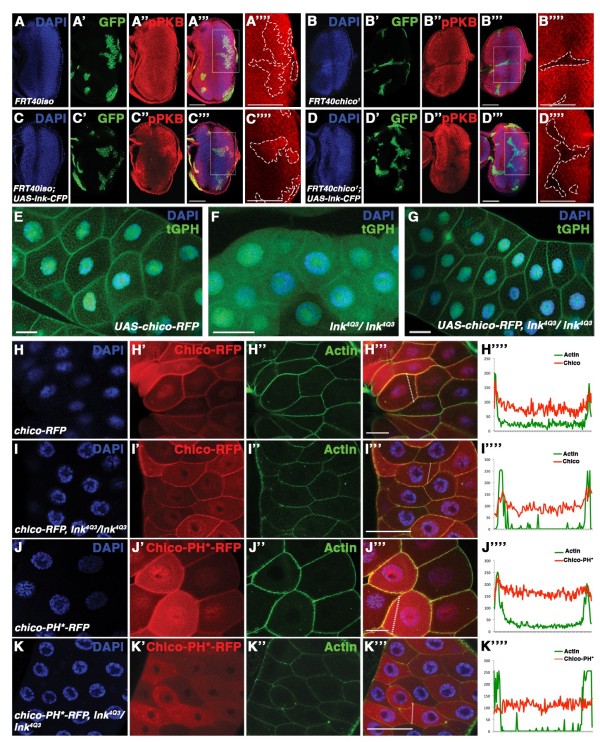
Lnk acts upstream of Chico ensuring its proper localisation. (A-D) Low phospho-PKB levels in chico−/− MARCM clones are not rescued by overexpression of lnk-CFP. Clones are marked by GFP expression (’ panels) and outlined by a dashed line in the detail pictures (”” panels). Phospho-PKB staining is shown in ” panels. (A-A””) control clones. (B-B””) Levels of phospho-PKB (B”) are decreased in chico−/− clones. (C-C””) Overexpression of lnk-CFP within control clones promotes high levels of phospho-PKB (C”). (D-D””) lnk-CFP overexpression within chico−/− clones does not rescue low levels of phospho-PKB (D”). (E-G) Chico overexpression restores localisation of the tGPH reporter at the membrane in lnk−/− salivary glands. (E) tGPH reporter localises at the membrane in wild-type salivary glands. (F) lnk4Q3 salivary glands show diffuse tGPH reporter signal in the cytoplasm. (G) tGPH reporter is recovered to the membrane of lnk4Q3 tissue by overexpressing chico. (H-K) Subcellular localisation of RFP-tagged Chico. The RFP signal is shown in ’ panels. Actin staining marks the cellular cortex in ” panels. Merged pictures are shown in ”’ panels. Signal intensities along the lines indicated in the ”’ panels are displayed in ”” panels. Quantifications in Additional file 1: Figure S1A. (H-H””) Cortical localisation of Chico-RFP in a wild-type situation. (I-I””) Chico-RFP in a lnk mutant background. (J-J””) A PH domain mutant form of Chico localises at the cortical membrane. (K-K””) Chico-PH*-RFP in a lnk mutant background. Number of samples analysed: (A) n=9, (B) n=9, (C) n = 10, (D) n = 12, (E) n=5, (F) n=5, (G) n=6, (H) n=6, (I) n=9, (J) n=6, (K) n = 6. Scale bars represent 50 μm.